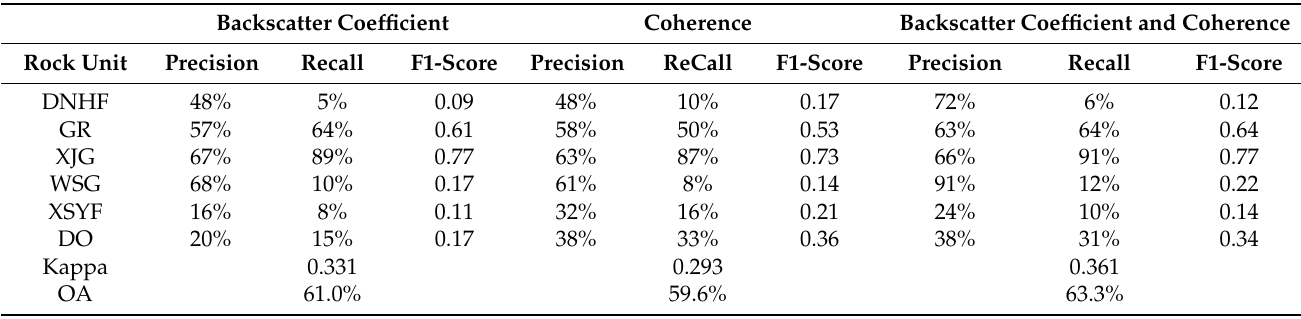
Table 8. Accuracy assessment of the result using time-series backscatter coefficient, coherence, and both backscatter coefficient and coherence at VH channel. Backscatter Coefficient Coherence Backscatter Coefficient and Coherence Rock